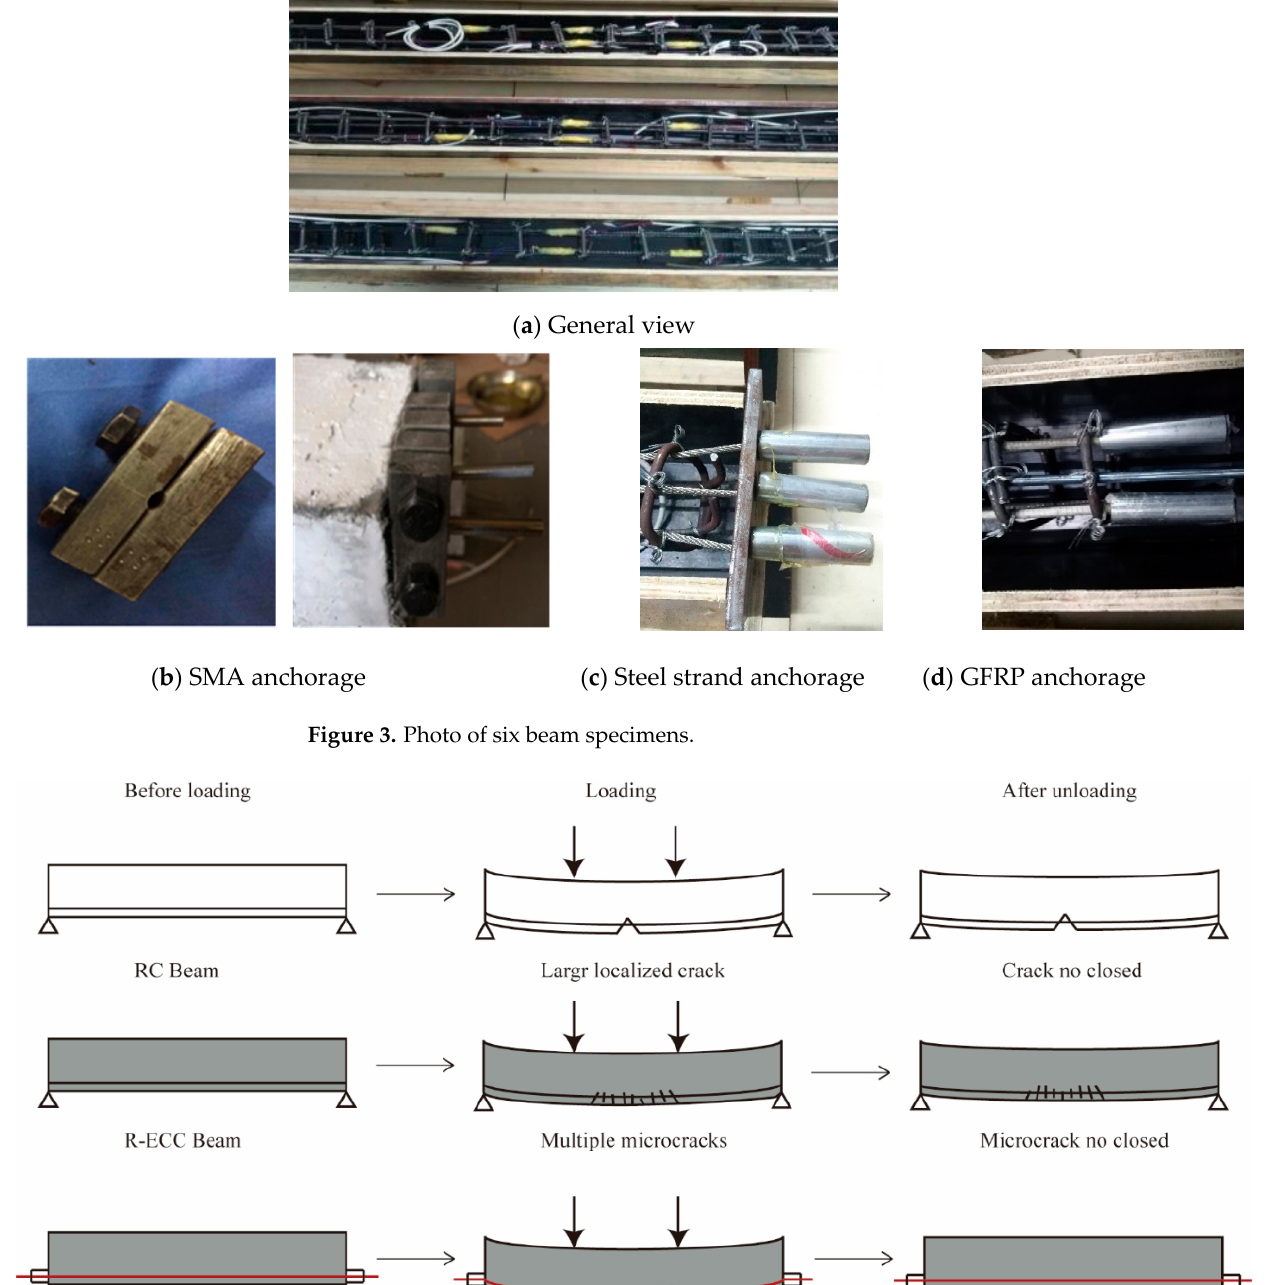
Figure 4. Schematic drawing of crack changes.